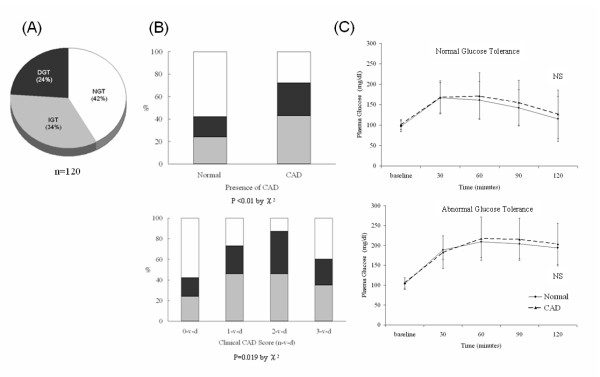
The distributions of glucose tolerance (GT) and CAD status, as well as the PG response curve during 75 g-OGTT. (A) After 75 g OGTT, the proportions of IGT and T2DM are 34% and 24%, respectively. (B) Frequency distribution of GT status in the presence of CAD or among the clinical (1- to 3- vessels diseases) scores. Significantly higher percentages of AbnGT (IGT and/or T2DM) are associated with CAD by chi-square analysis (both P values < 0.05). The white, light grey and dark grey areas indicate the percentage of NGT, IGT and T2DM, respectively. (C) No significant differences in PG response curves between CAD and non-CAD patients in either NGT or AbnGT group during the entire course of 75 g-OGTT.